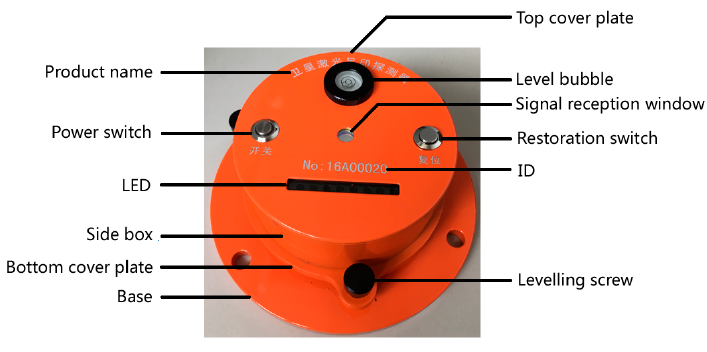
Figure 11. Laser Figure 11. Laser detector. Figure 11. Laser detector.